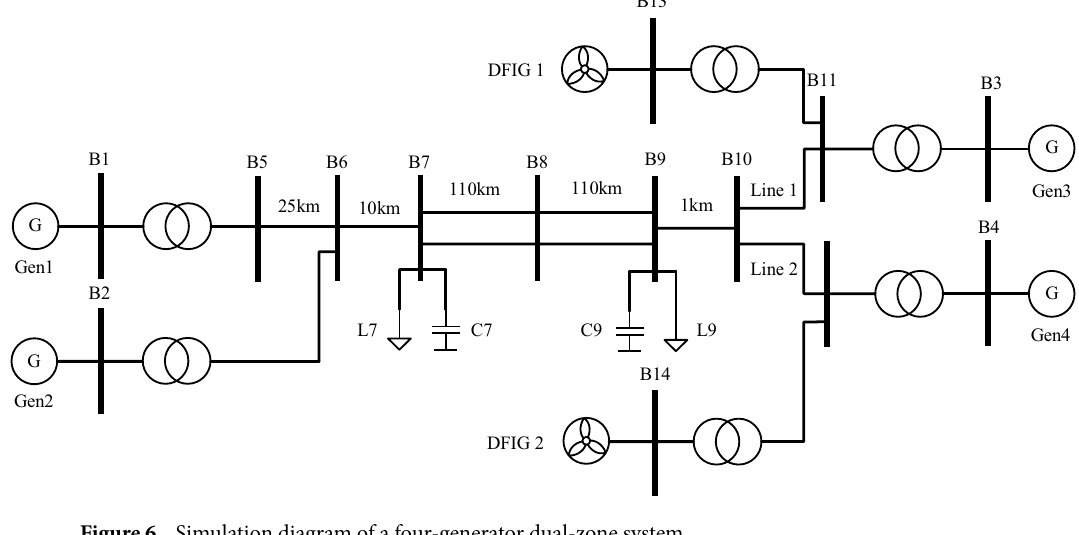
Figure 6. Simulation diagram of a four-generator dual-zone system.